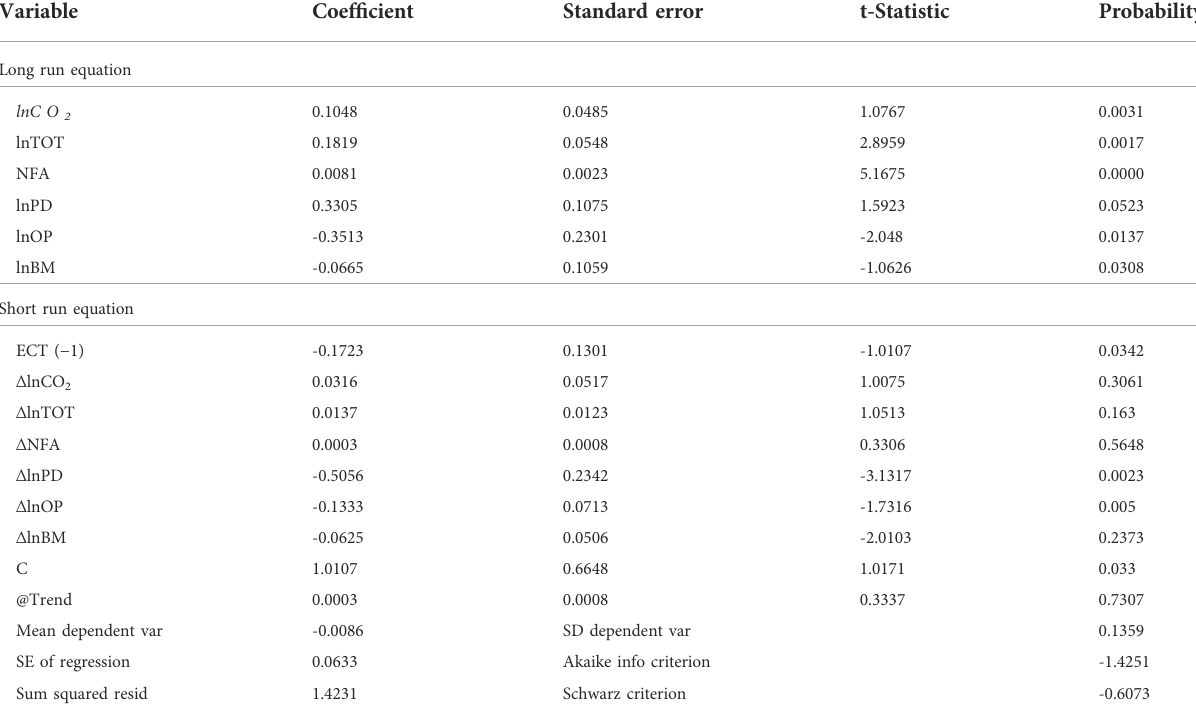
TABLE 3 The PMG/ARDL estimation results for real exchange rate model.